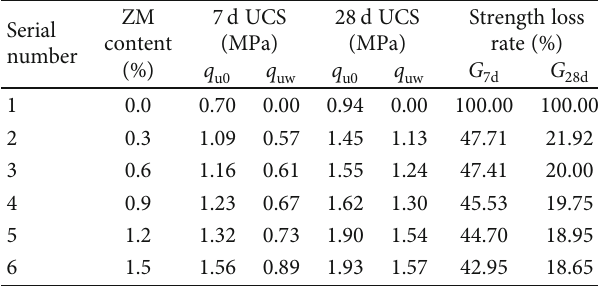
Table 5: One wetting-drying circle of specimens at di ff erent curing times.